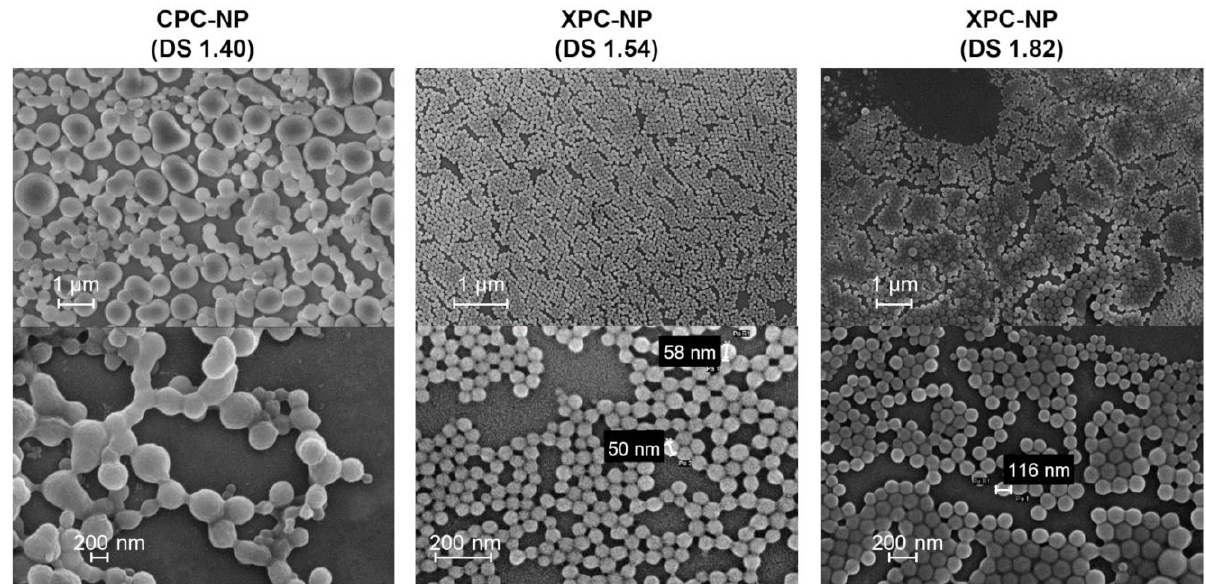
Figure 2. Scanning electron microscopy images of nanoparticles (NP) obtained by self-assembling of cellulose phenyl carbonates (CPC) and xylan phenyl carbonates (XPC) with different degrees of substitution (DS).